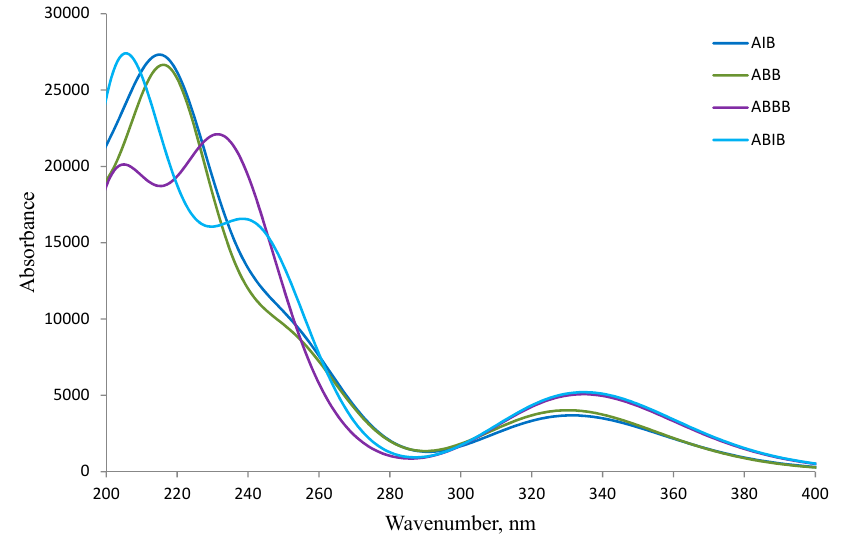
Figure 4. Simulated UV-Vis spectra of ABB , AIB , ABBB , and ABIB in DMSO.